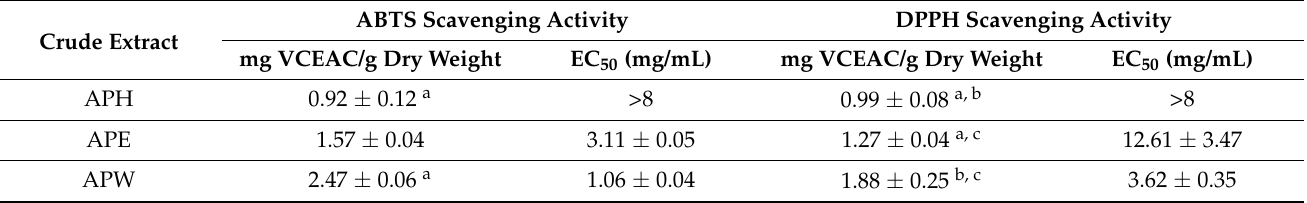
Table 1. Antioxidant capacity and half-maximal effective concentration (EC 50 ) of free radical scavenging activity of AP crude extracts. Crude Extract